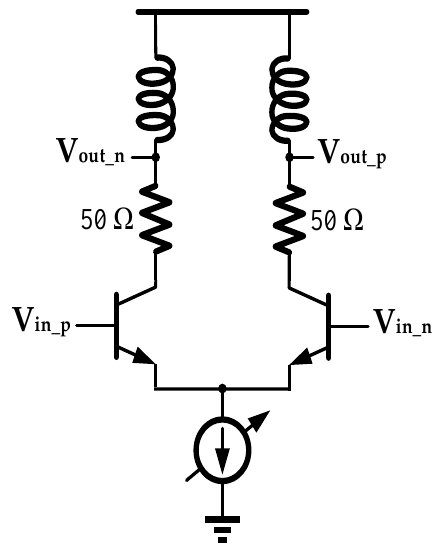
Figure 11. A schematic of the output stage.